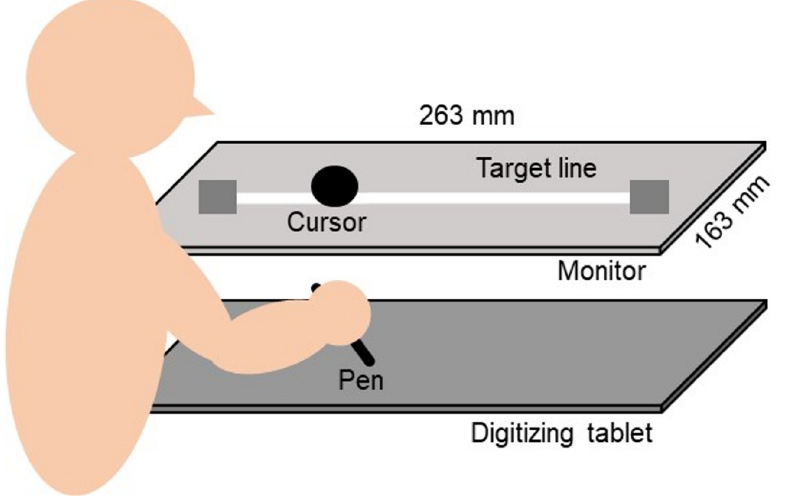
Fig 2. Experimental